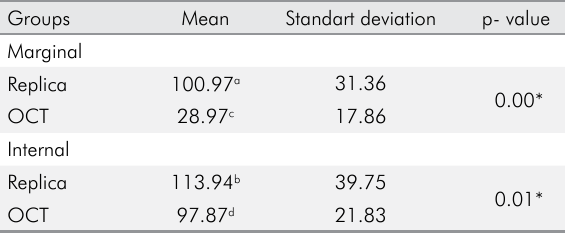
Table 1. Mean marginal and internal adaptation values (μm) of inlays according to measurement techniques (n =